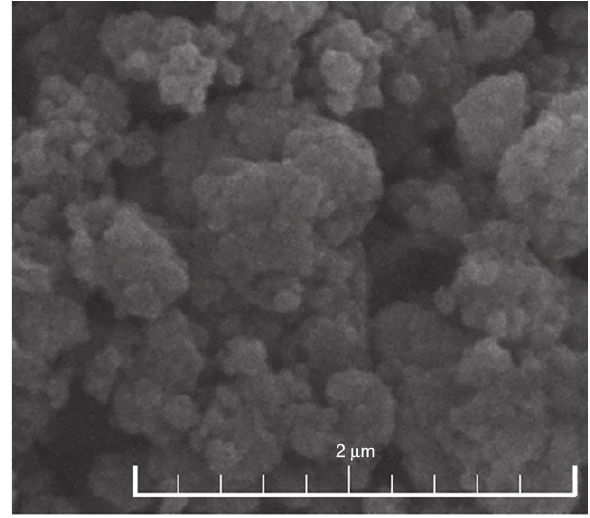
Figure 1 SEM micrograph of TiO